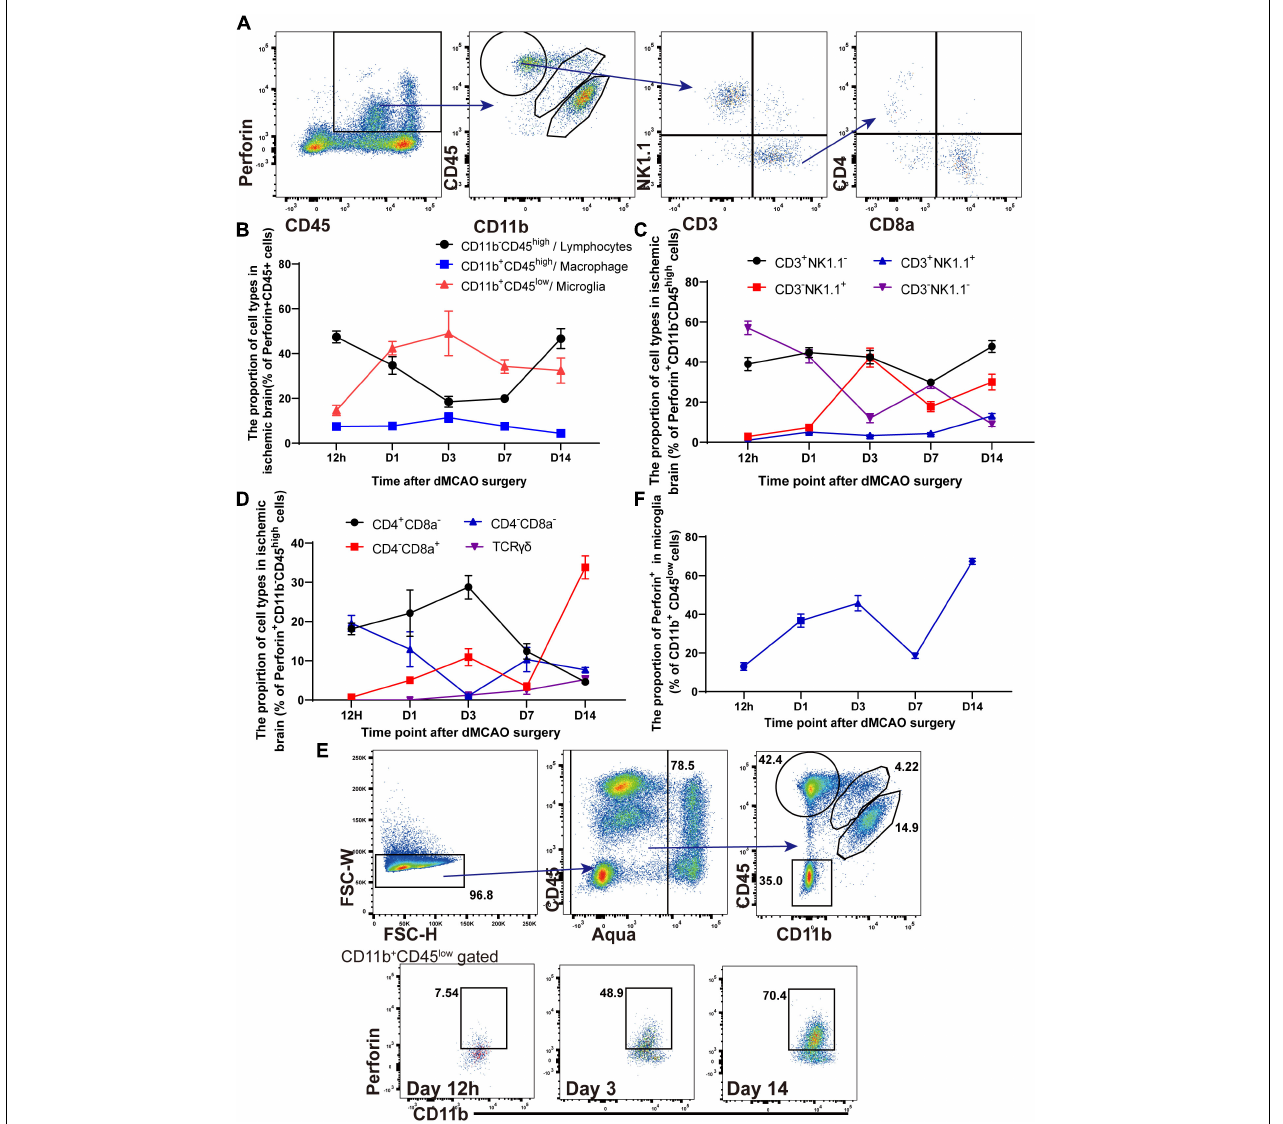
FIGURE 2 | The kinetics and heterogeneity of Perforin + CD45 + cells in the ischemic brain. (A) The percentages of Perforin + CD11b + CD45 low microglia, Perforin + CD11b + CD45 high macrophages, and Perforin + CD11b - CD45 high lymphocytes in the ischemic brain were measured by flow cytometry. CD3 + NK1.1 - cells was derived from perforin + CD11b - CD45 high lymphocytes and divided into CD4 + and CD8 + T cells. (B) The numbers of perforin + CD45 + lymphocytes, macrophages, and microglia after ischemic stroke at these time points. (C) The numbers of NK, NKT, CD3 - NK1.1 - , and CD3 + NK1.1 + cells among perforin + CD11b - CD45 high lymphocytes after ischemic stroke at these time points. (D) The numbers of CD4 + CD8 - , CD4 - CD8 + , CD4 - CD8 - and CD3 + TCR γδ + cells among perforin + CD11b - CD45 high lymphocytes after ischemic stroke at these time points. (E) Flow cytometry showed the ability of Aqua - CD11b + CD45 low microglia to secrete perforin. (F) The proportion of Prf1-GFP among Aqua - CD11b + CD45 low microglia after dMCAO. The data are shown as the mean ± SEM; n = (6–10) mice per